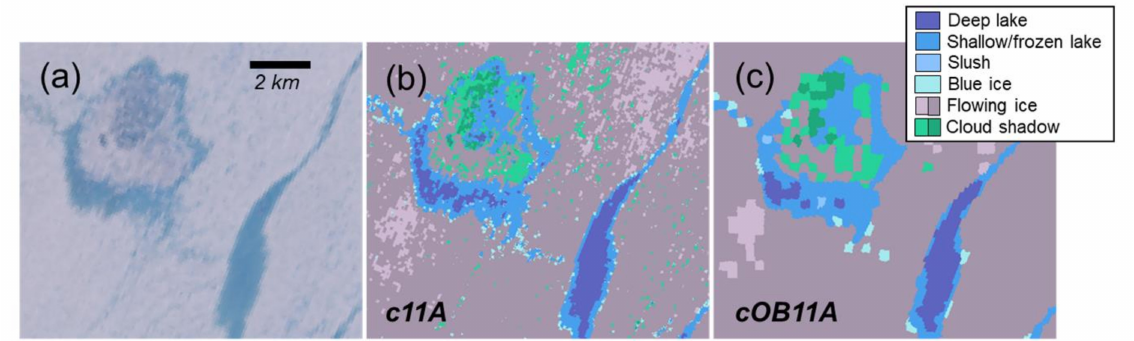
Figure 6. A subset of Landsat scene LC08_L1GT_127111_20140204 is shown in true color ( a ), alongside results from pixel-based ( b ) and object-based ( c )